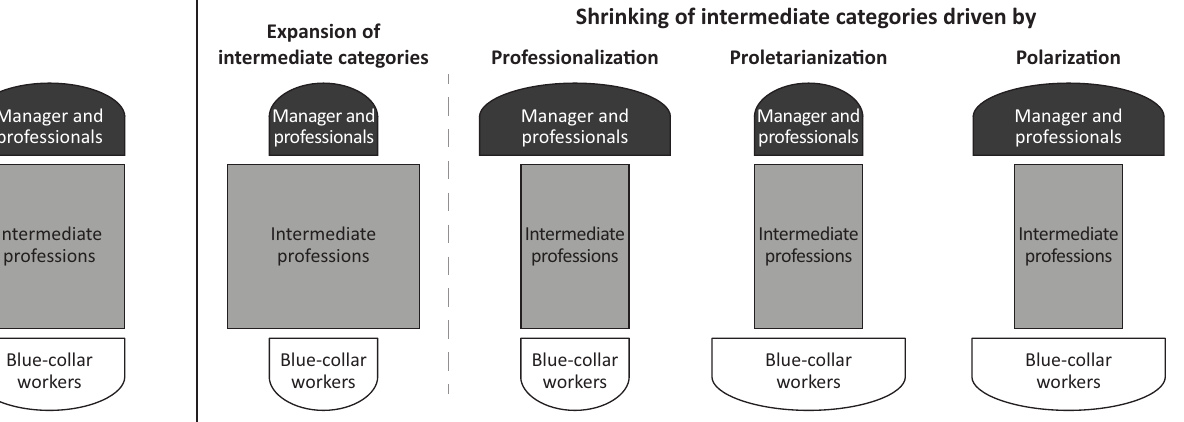
Figure 1. Major types of social change in terms of